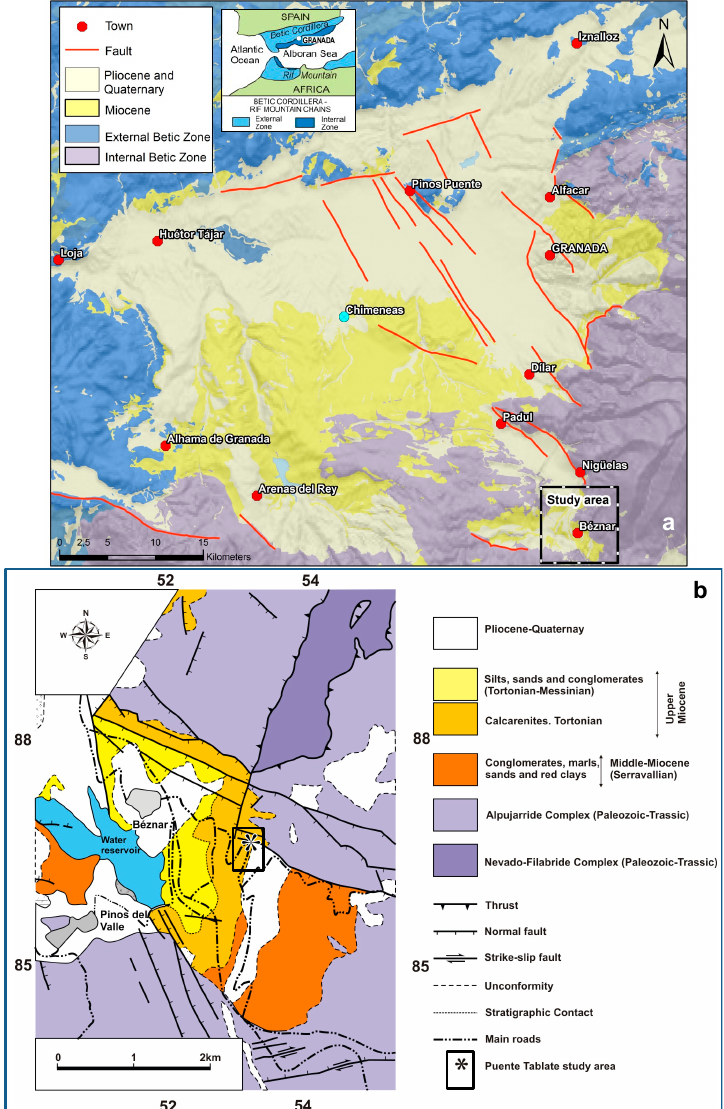
Figure 2. ( a ) Geological sketch of the Granada Basin and the Betic Cordillera, southern Spain. ( b ) Geological map of the study area. Location of the area is indicated in ( a ). Modified from Sanz de Galdeano [71].